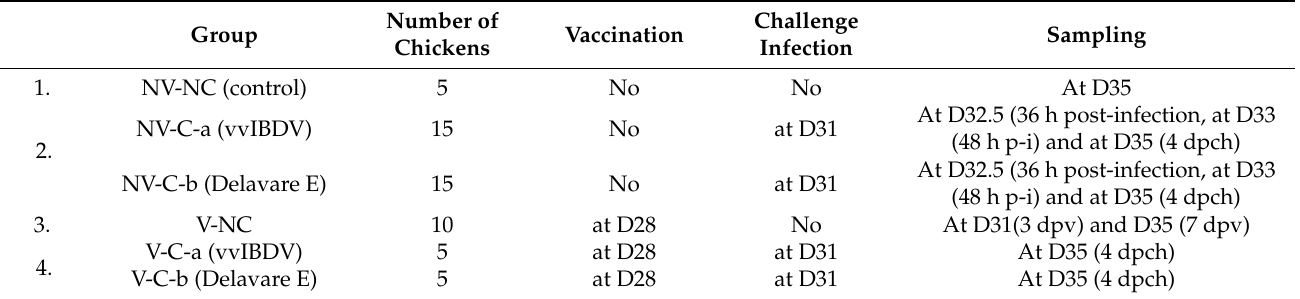
Table 1. Outline of the animal phase of the trial. Dates indicate the age of the chickens at the given action in days. Abbreviations: days post-vaccination (dpv) and days post challenge